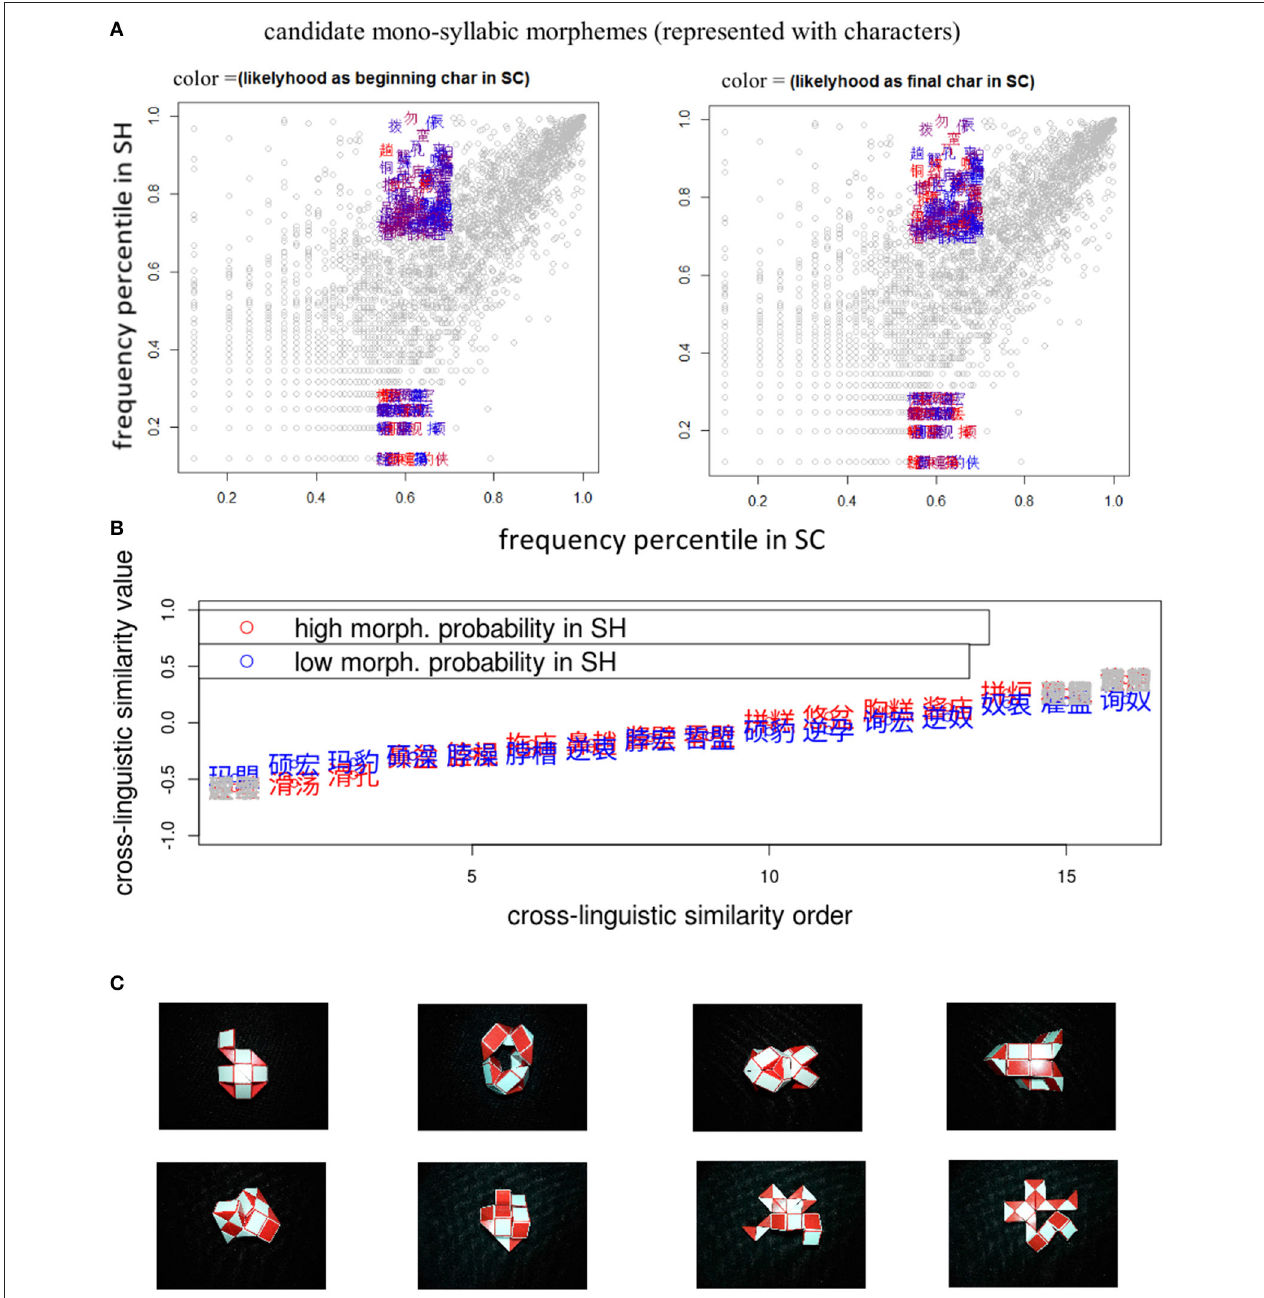
FIGURE 3 | (A) Upper panel: scattered plots for candidate mono syllabic ETE morphemes, represented with Chinese characters, plotted with frequency percentiles in SC (along the horizontal axis) and SH (along the vertical axis), colored from blue (low) to red (high), according to the likelihood as beginning (left sub-plot) and final characters (right sub-plot). (B) Middle panel: scattered plots for two sets of disyllabic novel ETE pairs, represented with Chinese characters, plotted with the order (along the horizontal axis) and values (along the vertical axis) of cross-dialectal similarity, colored in blue for low morphological probability and in red for high morphological probability. Three pairs with extreme values of cross-dialectal similarity mismatching between sets were excluded from the analysis (colored in light gray). (C) Lower panel: images of unfamiliar shapes.